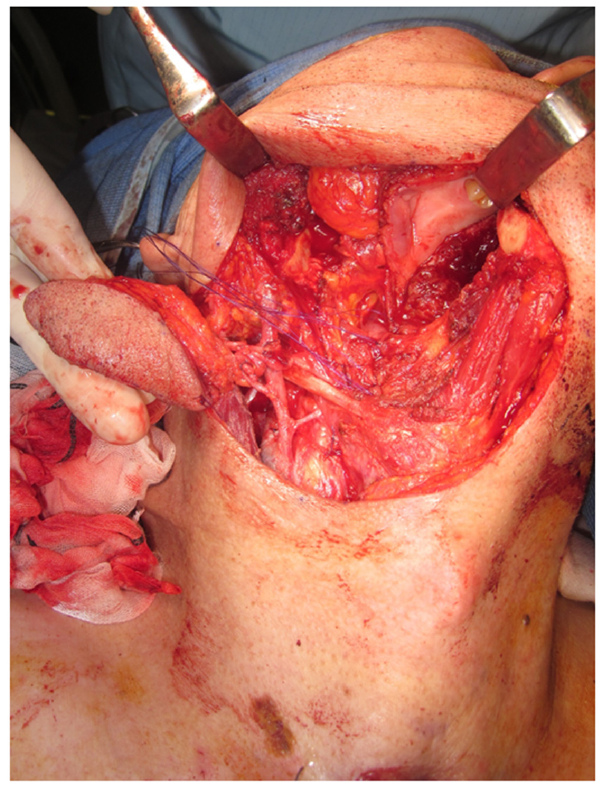
Figure 1. Submental artery flap in right